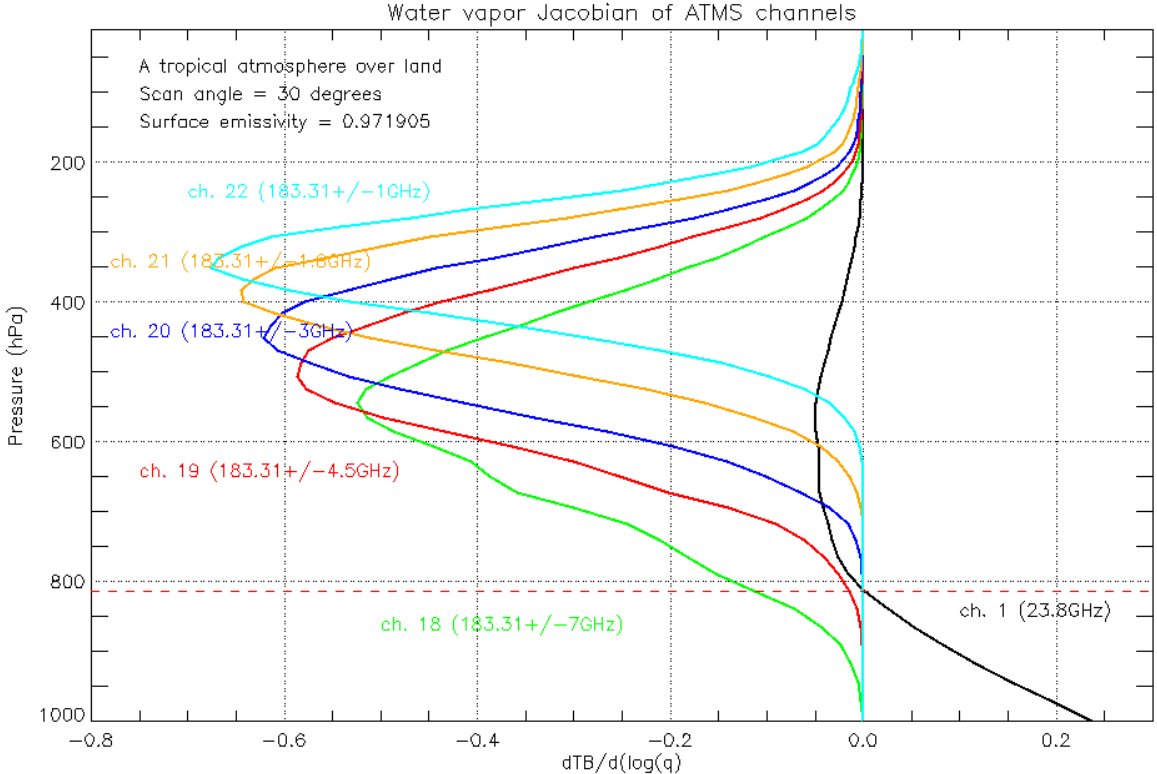
Figure 1. The sensitivities of the ATMS water vapor channels (1, 18 to 22) to an atmospheric profile of water vapor. The land surface emissivity of 0.971905 is chosen for all channels. Table 2. Comparisons of MiRS retrieved global total precipitable water (mm) between using all NOAA-20 ATMS channel measurements (operational) and ATMS measurements without channel 1 for March 15, 2019. The values in the red color are the relative change in the percentage of